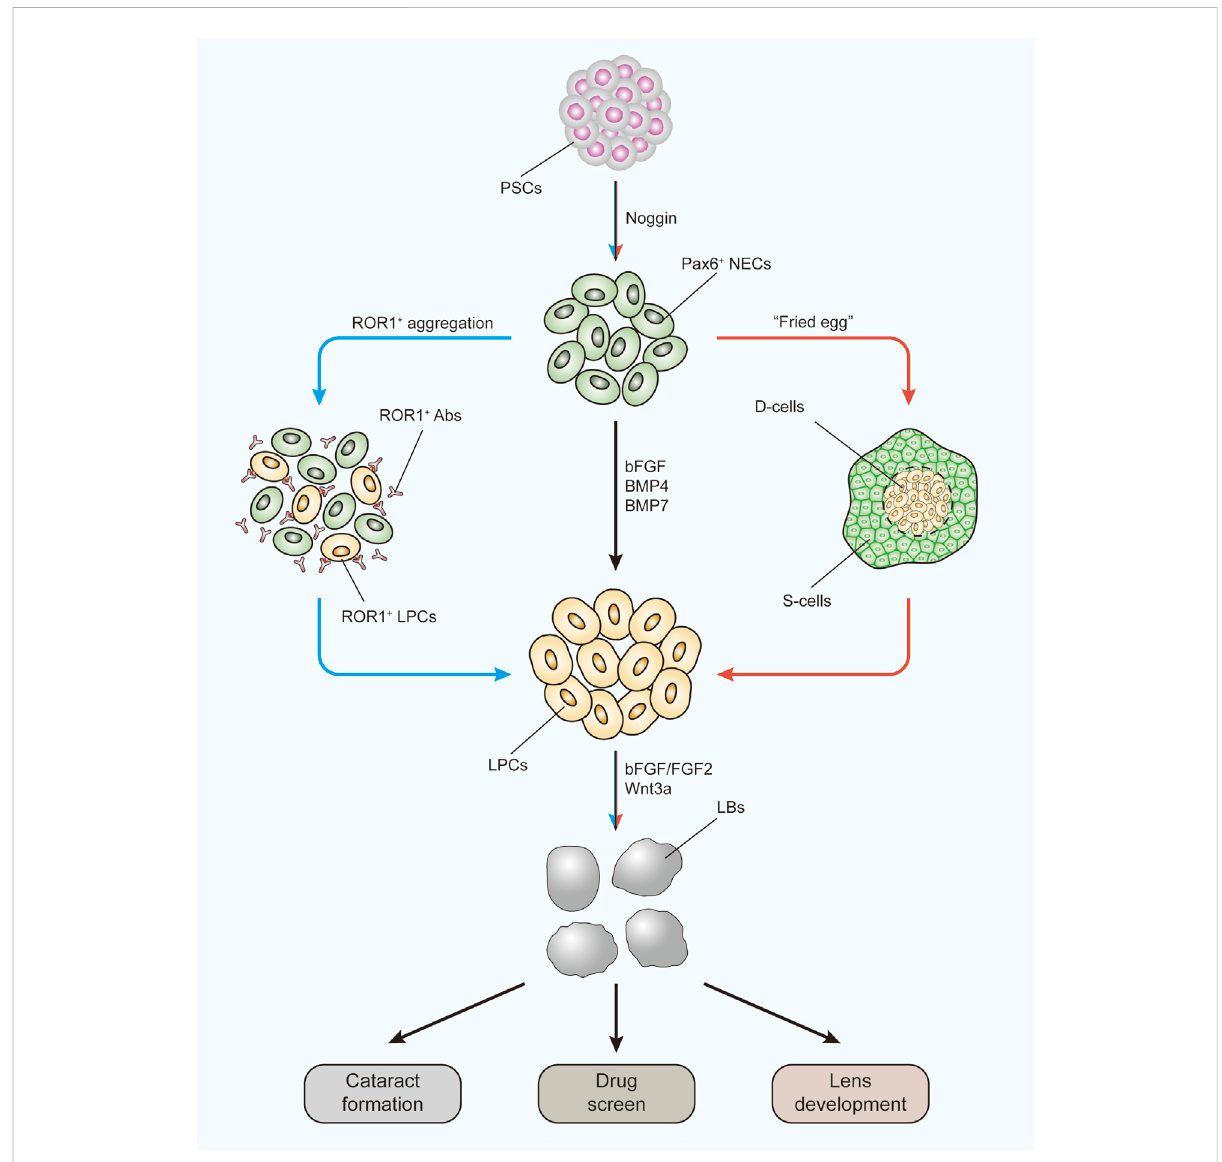
Three-stageprotocoltoformLBsfromhumanPSCsusingtwoimprovedmethods. Theblackarrowindicatesthemainrouteofthethree-stage protocol. The bluearrow indicatestheROR1 + LPCaggregationmethods. Thered arrowindicates the “ friedegg ” method. LBsgenerated underthese protocols can be used to study the mechanism of cataract formation, to apply drug screens, and to investigate lens development. PSCs, pluripotent stemcells;NECs,neuroectodermalcells;Abs,antibodies;LPCs,lensprogenitorcells;D-cells,differentiatingcells;S-cells,supportingcells;LBs, lentoid